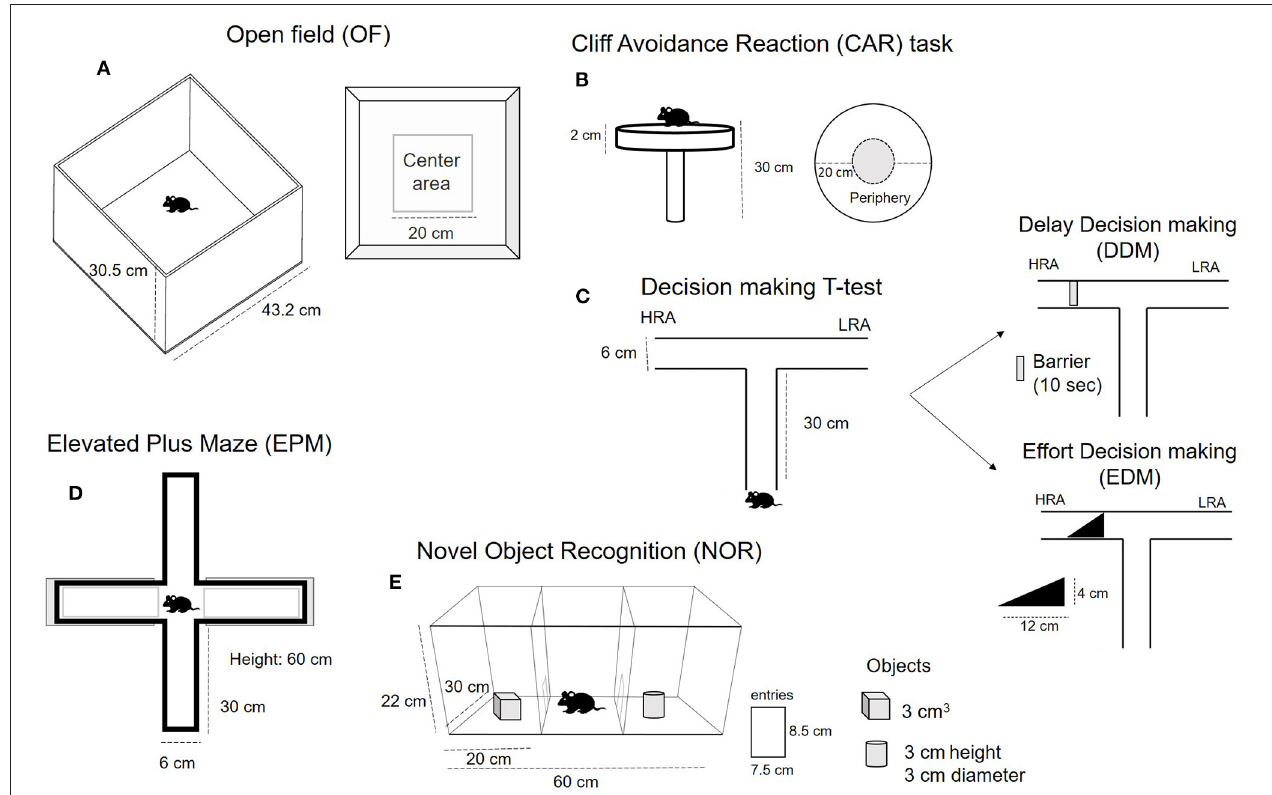
FIGURE 1 | Schematic representation of the behavioral tests used to characterize specific behavior in adolescent male and female DAT- Cnr2 cKO mice in comparison with WT mice.